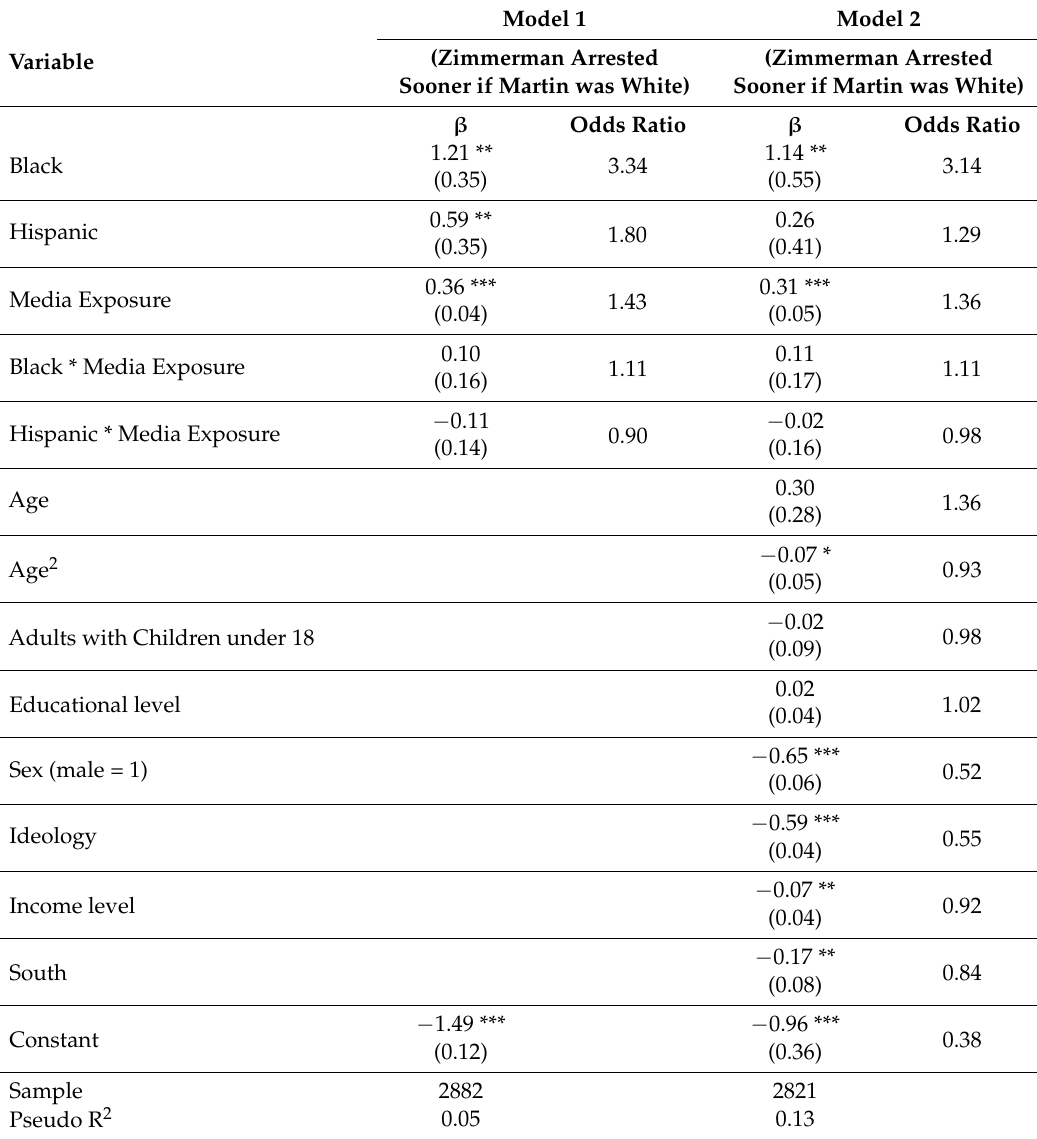
Table 2. Media Exposure and Attitudes Toward the Delayed Arrest of George